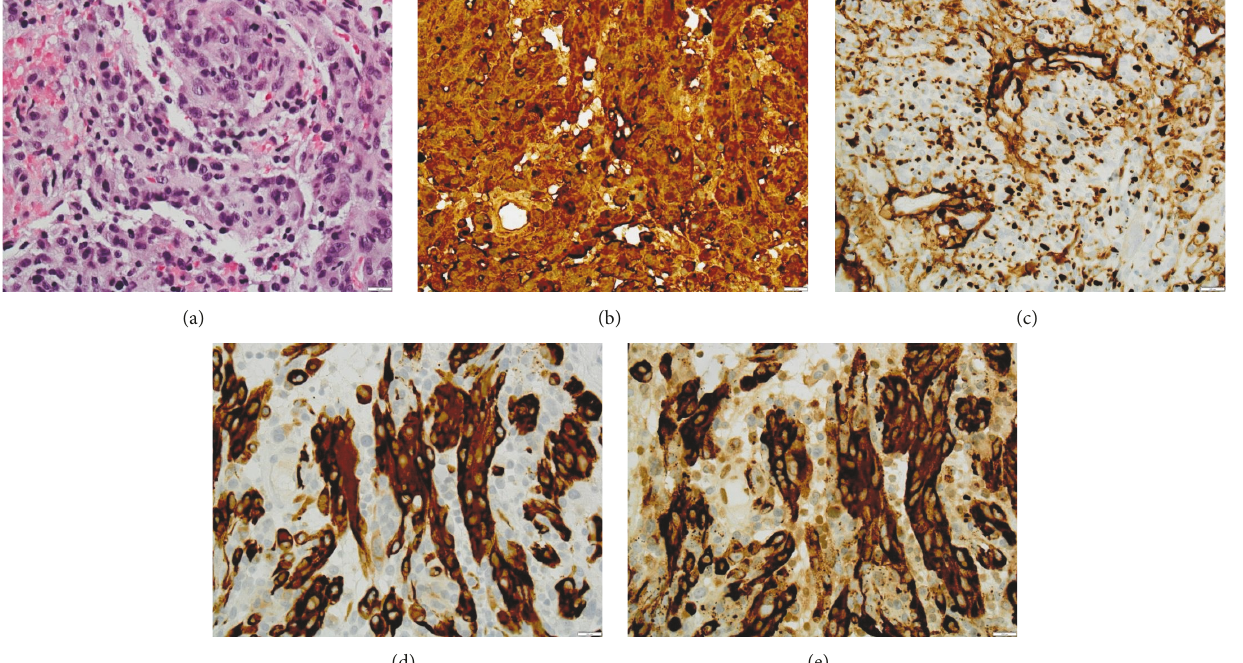
Figure 5: (a) Hematoxylin and eosin-stained section of CP angle tumor; immunostains for S100 (b), collagen IV (c), Mart1/Melan A (d), and HMB-45